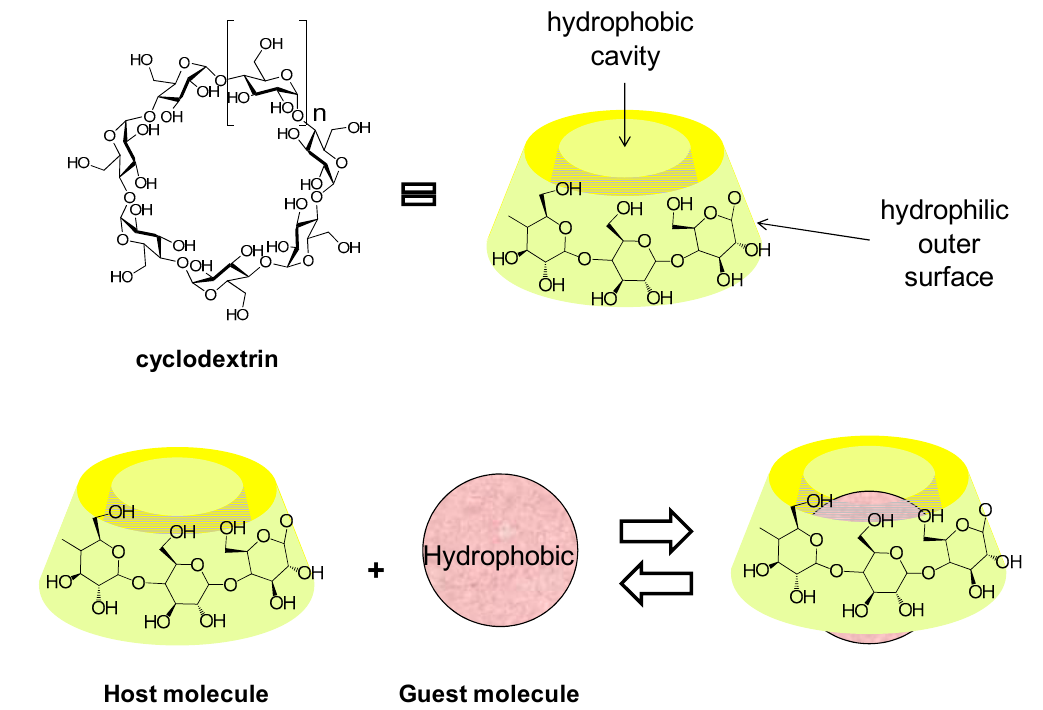
Figure 2. ( A ) chemical structure of β -cyclodextrin and ( B ) exchange in host–guest systems implying cyclodextrin.